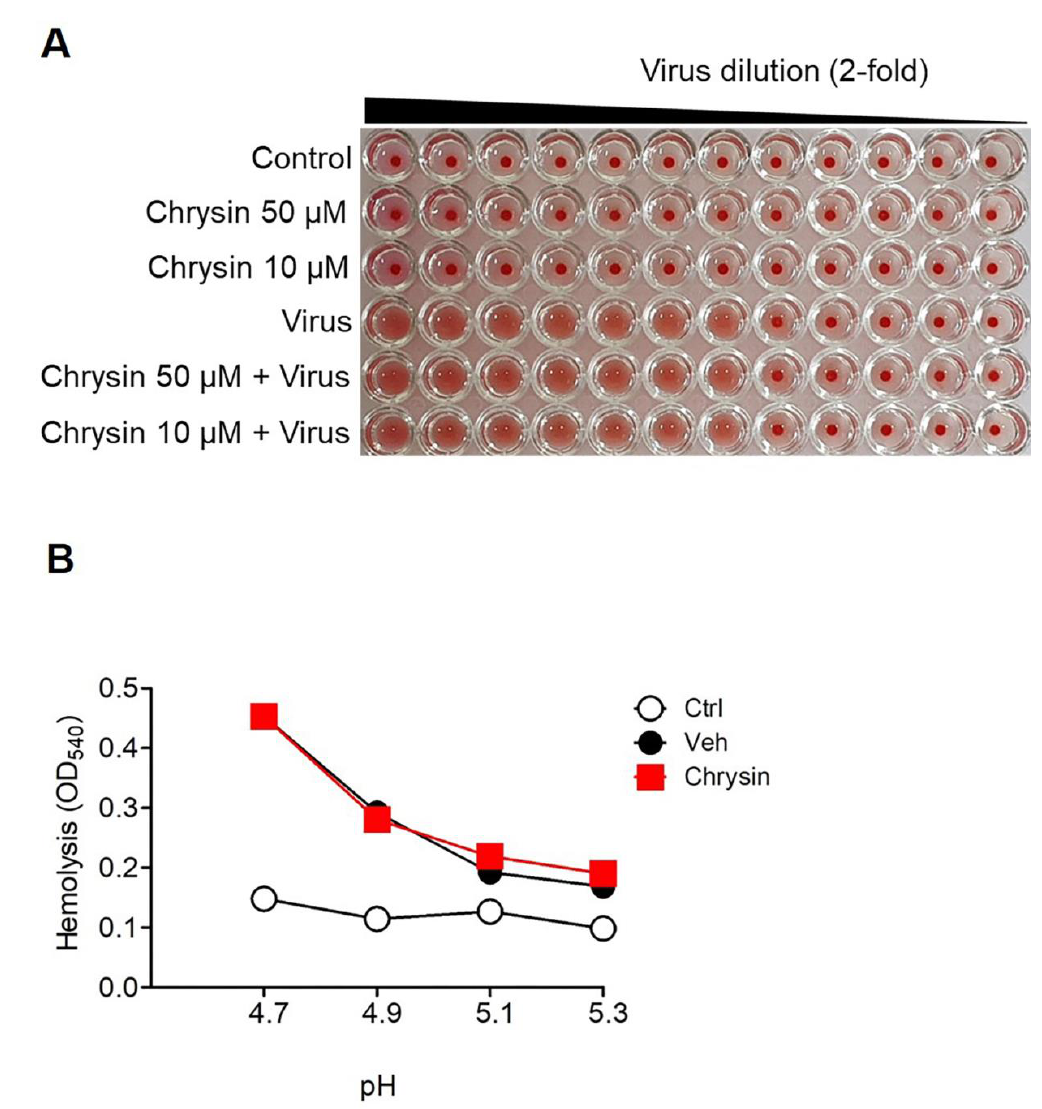
Figure 3. Chrysin did not inhibit the entry and fusion of A/PR/8. ( A ) Hemagglutination assay was performed as indicated in the Materials and Methods section. Chicken erythrocytes (cRBCs) were mixed with A/PR/8 in PBS and chrysin (50 µM and 10 µM) or with the vehicle (PBS containing 0.05% DMSO). ( B ) For the hemolysis inhibition assay, a mixture of chrysin (50 µM) and A/PR/8 was added to freshly prepared cRBCs. The pH condition of the mixture was adjusted to 4.7, 4.9, 5.1, and 5.3, and then incubated at 37 °C for 30 min. After a brief spin, the absorbance of the released hemoglobin contained in the supernatants was measured at 540 nm.